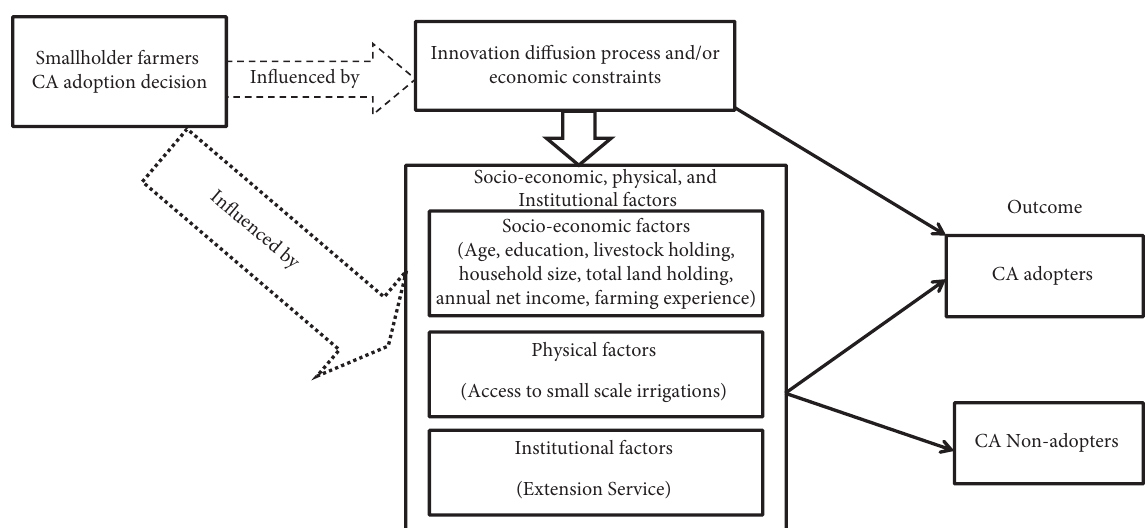
Figure 2: Conceptual framework adapted from Zeleke